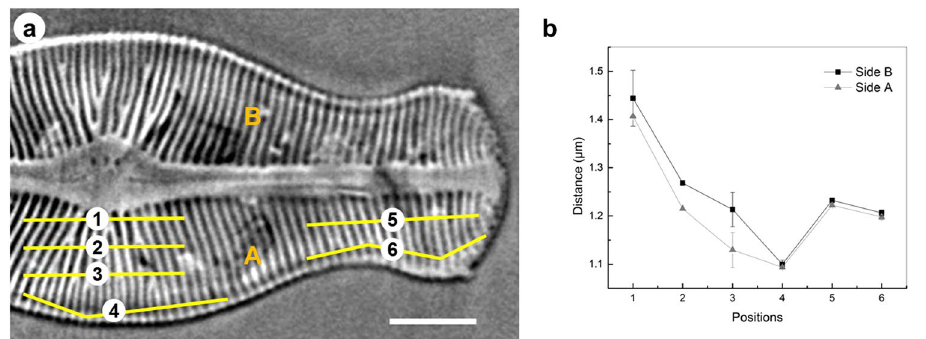
Figure 7. ( a ) The measurement of the rib distance at several positions (from 1 to 6) in the valve view of the D. geminata frustule. ( b ) Statistics of the distance between the ribs from centre to centre and from the centre area to the edge area of the D. geminata frustule. Scale bar: 10 µ